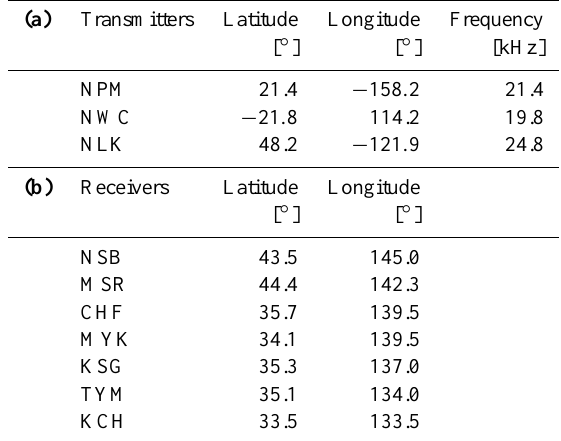
Table 1. Geophysical coordinates and transmitting frequencies of VLF/LF stations used in this paper, (a) transmitters and (b) re-